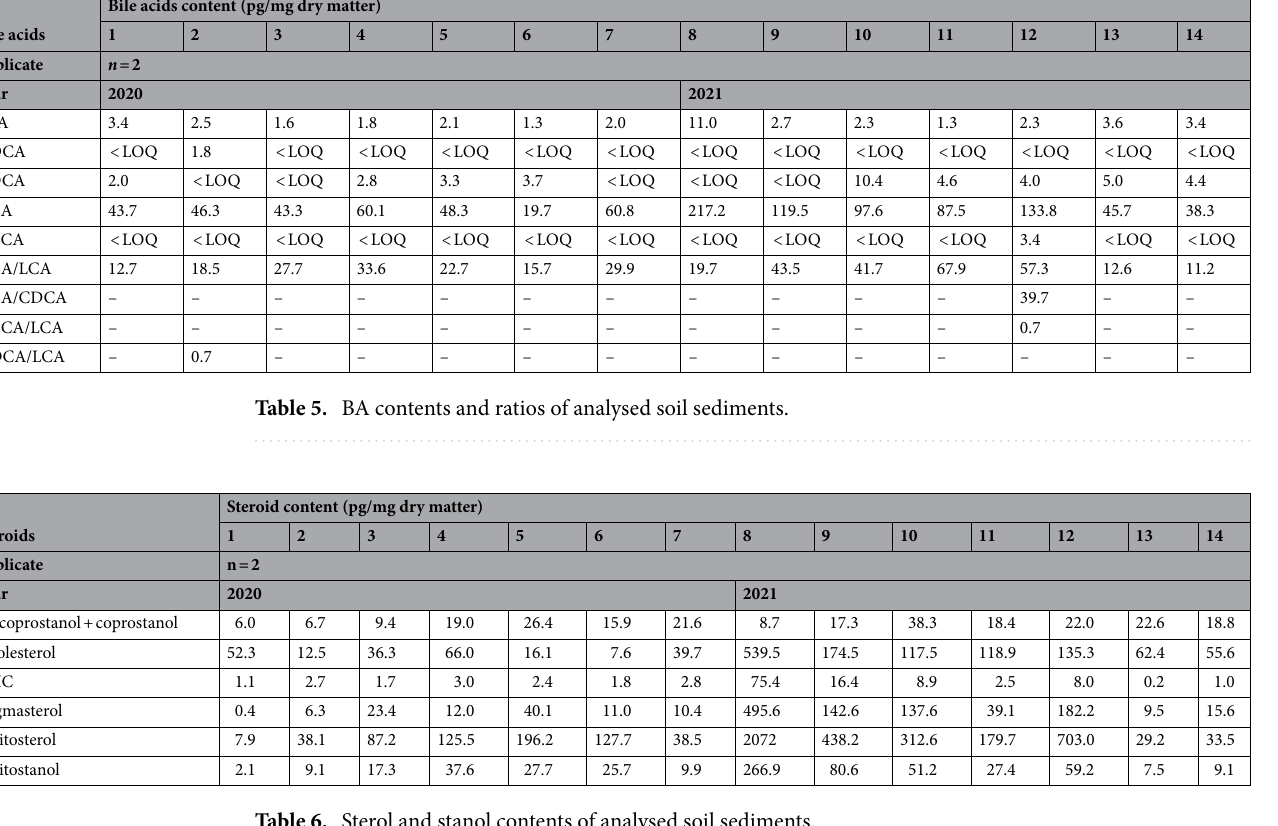
Table 6. Sterol and stanol contents of analysed soil